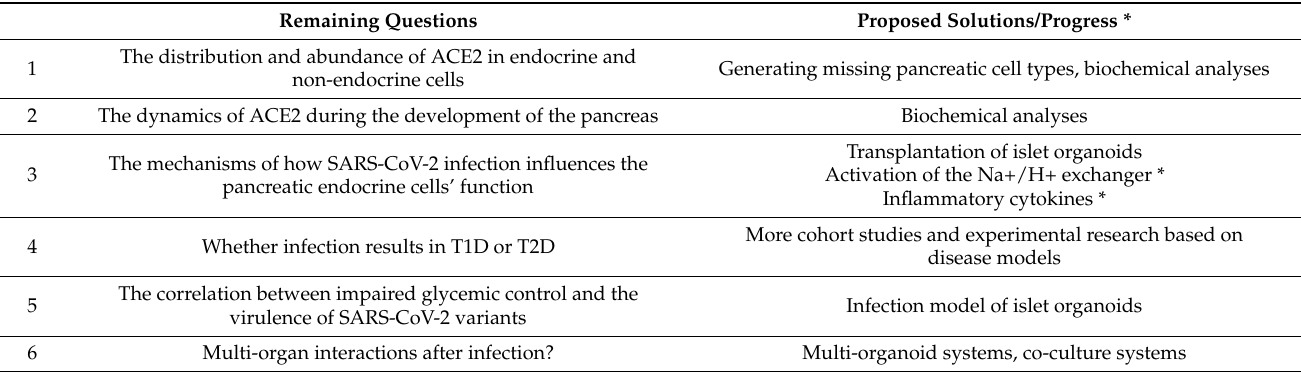
Table 2. Remaining questions and proposed solutions (* indicates progresses that have been made by